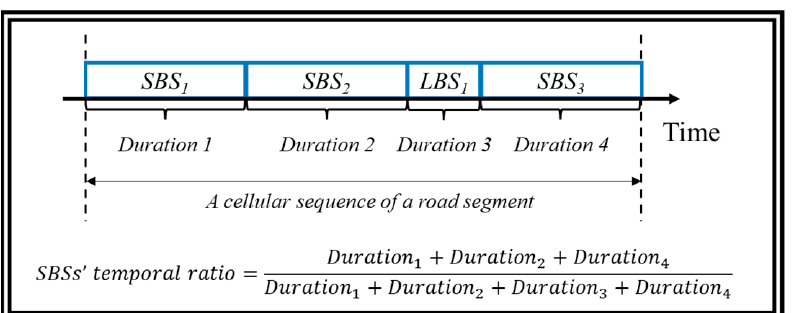
Figure 10. An intuitional illustration of SBSs’ temporal ratio. LBS represents the Labile impacting Base Station, which is opposite to the SBS. Notice that the average SBS temporal ratio of 24 × 8 = 192 cellular signaling sequences is 83.34%. Among all cellular signaling sequences, such a ratio is up to 90% for 61.80% of them, which is shown in Figure 11.